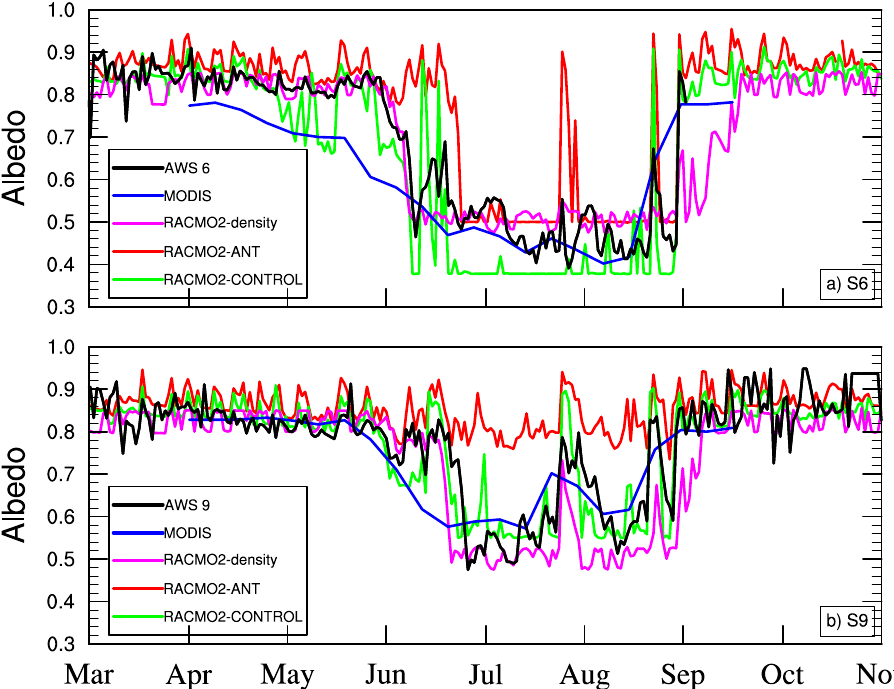
Fig. 5. Albedo for the year 2007 at location S6 (top) and S9 (bottom) for AWS measurements (black), MODIS retrievals (blue), RACMO2 simulations with the density dependent albedo scheme (magenta) and the new albedo scheme using the ANT (red) and CONTROL (green) settings.